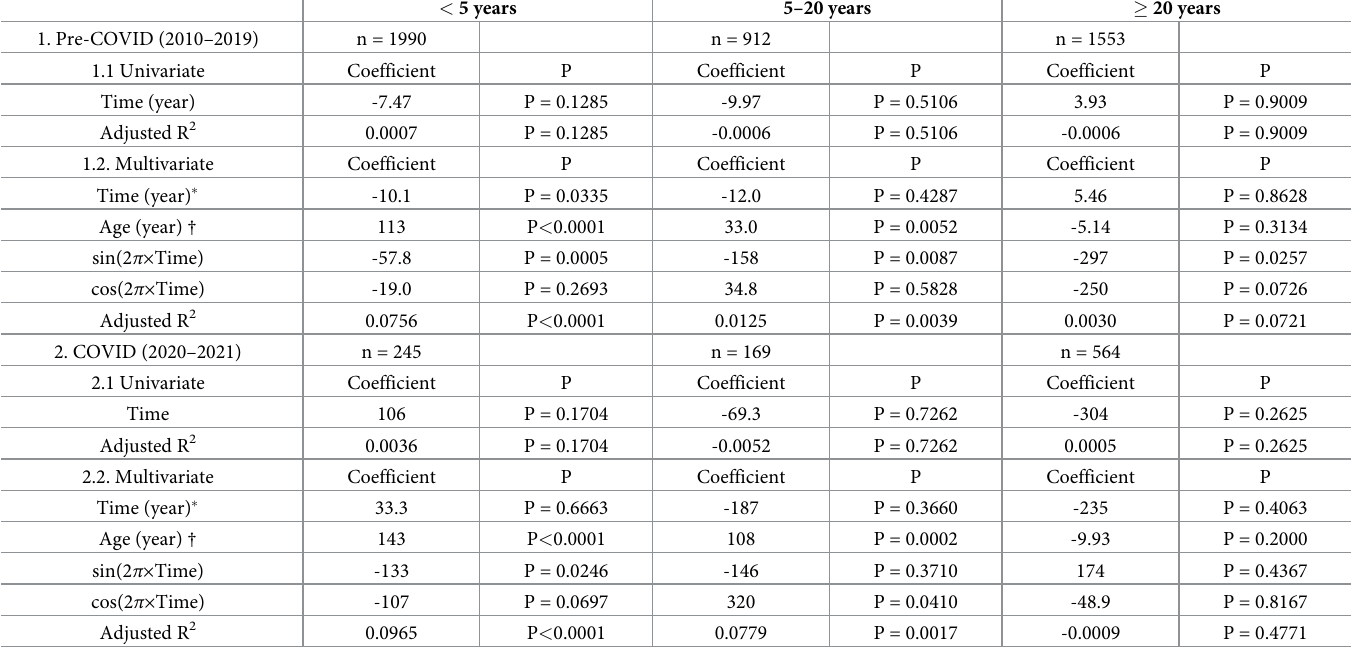
Table 3. Regression analysis to explain IgE in different age